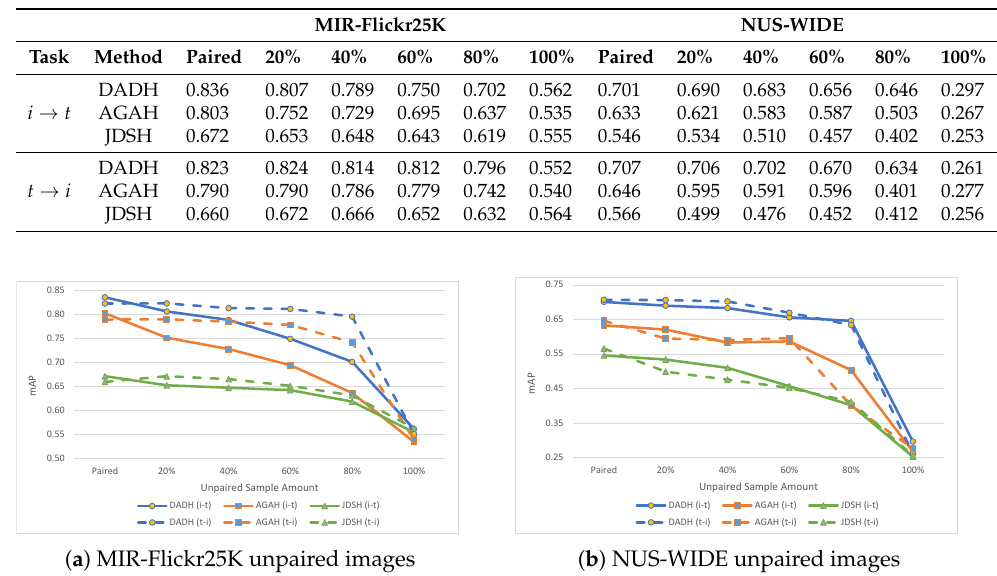
Figure 5. Results (mAP) on MIR-Flickr25K and NUS-WIDE with unpaired images, i.e., images with no corresponding text. The ‘Paired’ points show results when training with a fully paired training set. Subsequent points show results with increasing amounts of unpaired images in the training set in increments of